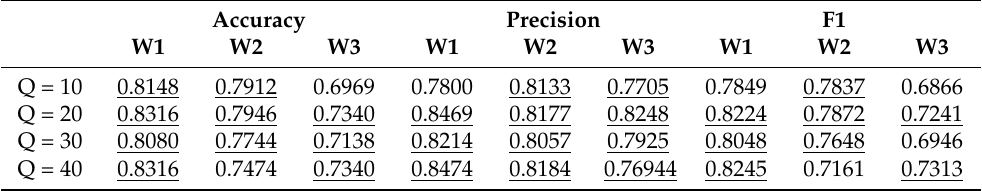
Table 5. Evaluation of W1, W2 and W3’s personalized models generated with no AL dataset bias after Q = 10,20,30,40 queries, using their corresponding evaluation datasets. Underlined results mean increased metrics in comparison with the corresponding FL